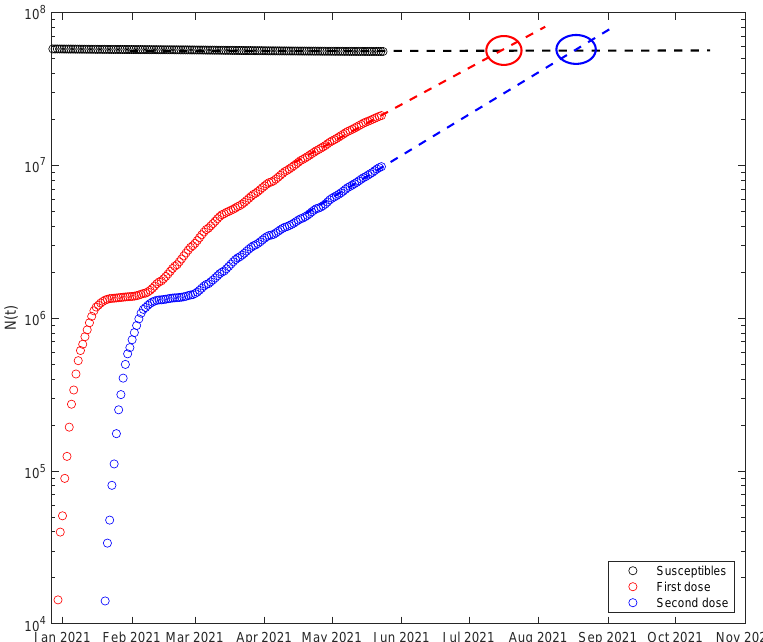
Figure 7. Semi-logarithmic plot of the intersection points between trends of Susceptible and vacci- nated people with first (red data) and second (blue data) doses (data available from [48]). Dotted lines correspond to data extrapolation for evaluating the intersection that may mark the end of the pandemic in